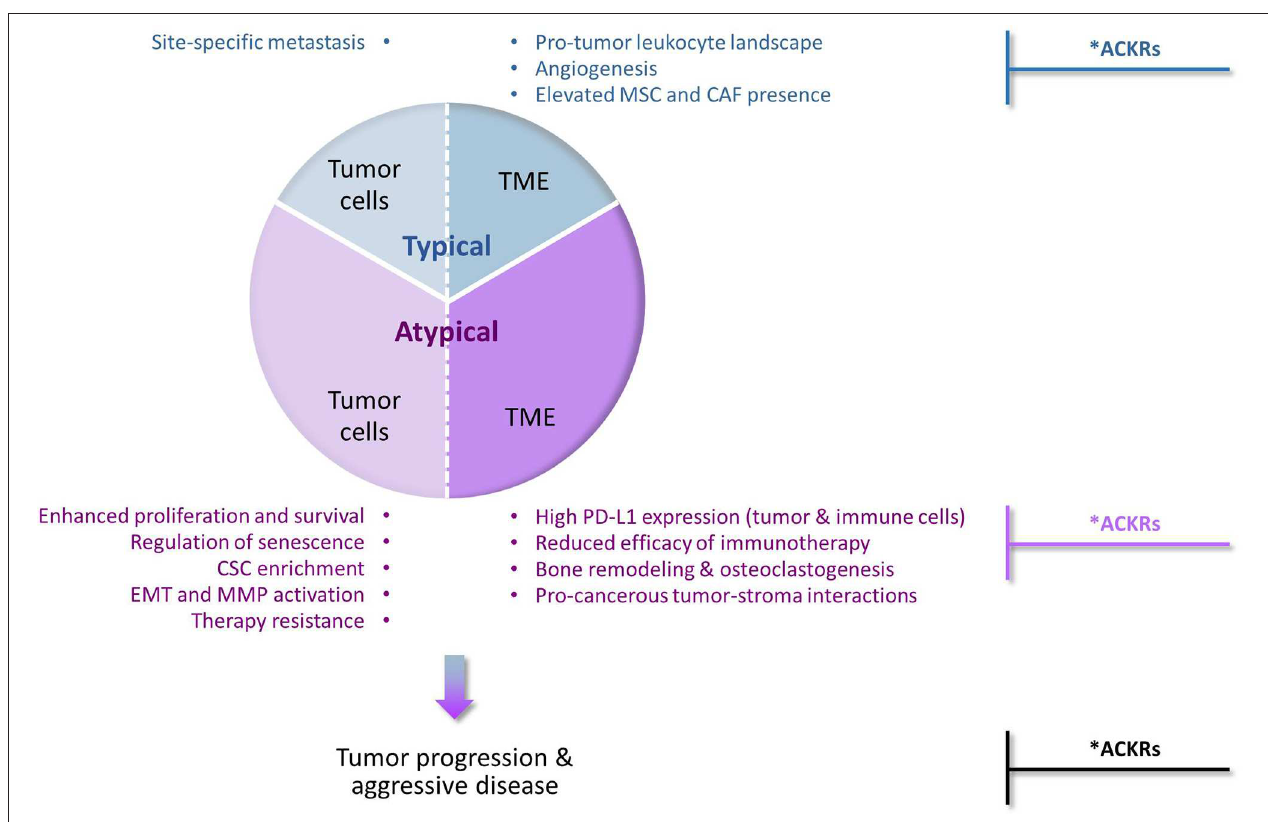
FIGURE 1 | Typical and atypical pro-tumor activities of chemokines and their receptors in cancer. The chemokine family contains many different members, some of which can limit tumor progression for example by inducing the recruitment of cytotoxic immune cells to tumors, or by inducing angiostasis (e.g., CXCR3). However, extensive investigations of chemokine roles in cancer indicate that chemokine activities that promote tumor development and progression are very common and often dominate the malignancy process. Being prime regulators of leukocyte migration in the immune context, chemokines are primarily considered as inducers of cellular motility. Accordingly, chemokine activities that promote tumor progression via induction of directional cell motility—of leukocytes, endothelial cells, stromal cells and cancer cells—are regarded in the scope of this review as “Typical”. Very much like the “Typical” chemokine activities, also those that do not directly affect cellular motility and are thus termed herein “Atypical”, can be exerted on the tumor cells or on the TME (tumor microenvironment). By addressing most of these aspects in breast cancer, we emphasize in this review article the atypical activities of chemokines in cancer (thus given a higher proportion in this drawing, but not necessarily so in the actual cancer setting). In the “Typical” part, we mention that typical chemokine-induced migration can lead to homing of cancer cells at specific metastatic sites and to remodeling of the tumor landscape by recruiting leukocytes, inducing angiogenesis through endothelial cell migration, and attracting MSCs that can then differentiate to CAFs. In parallel, in the “Atypical” part, we describe the roles of chemokines in reinforcing (1) the aggressiveness of the tumor cells, by elevating tumor cell proliferation and survival, regulating senescence, enriching tumors for CSCs, inducing EMT and MMP production and elevating resistance to chemotherapy and endocrine treatments; and (2) the pro-metastatic nature of the TME, by interfering with the activities of ICBs, remodeling the bone niche by elevating osteoclastogenesis and bone resorption, and promoting tumor-stroma interactions that contribute to elevated malignancy. Together, all of these chemokine effects—typical and atypical—eventually lead to elevated metastasis and worsening of disease course. *Anti-metastatic activities in cancer: Under specific settings, the pro-metastatic activities of chemokines can be inhibited by other chemokines that act through classical chemokine receptors (e.g., CXCR3) or by